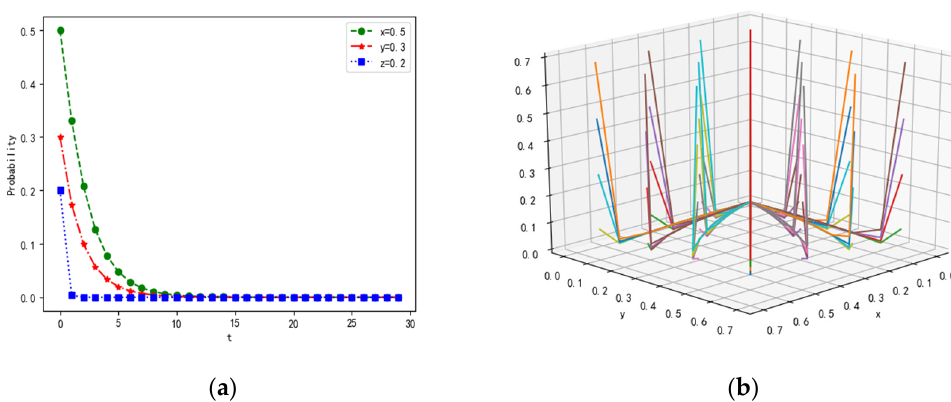
Figure 2. Evolutionary results of p 1 ( 0,0,0 ) are shown under a corresponding constraint condition, ( a ) represents the convergence of probability with time, and ( b ) shows the results of dynamic simulation in three dimensions.